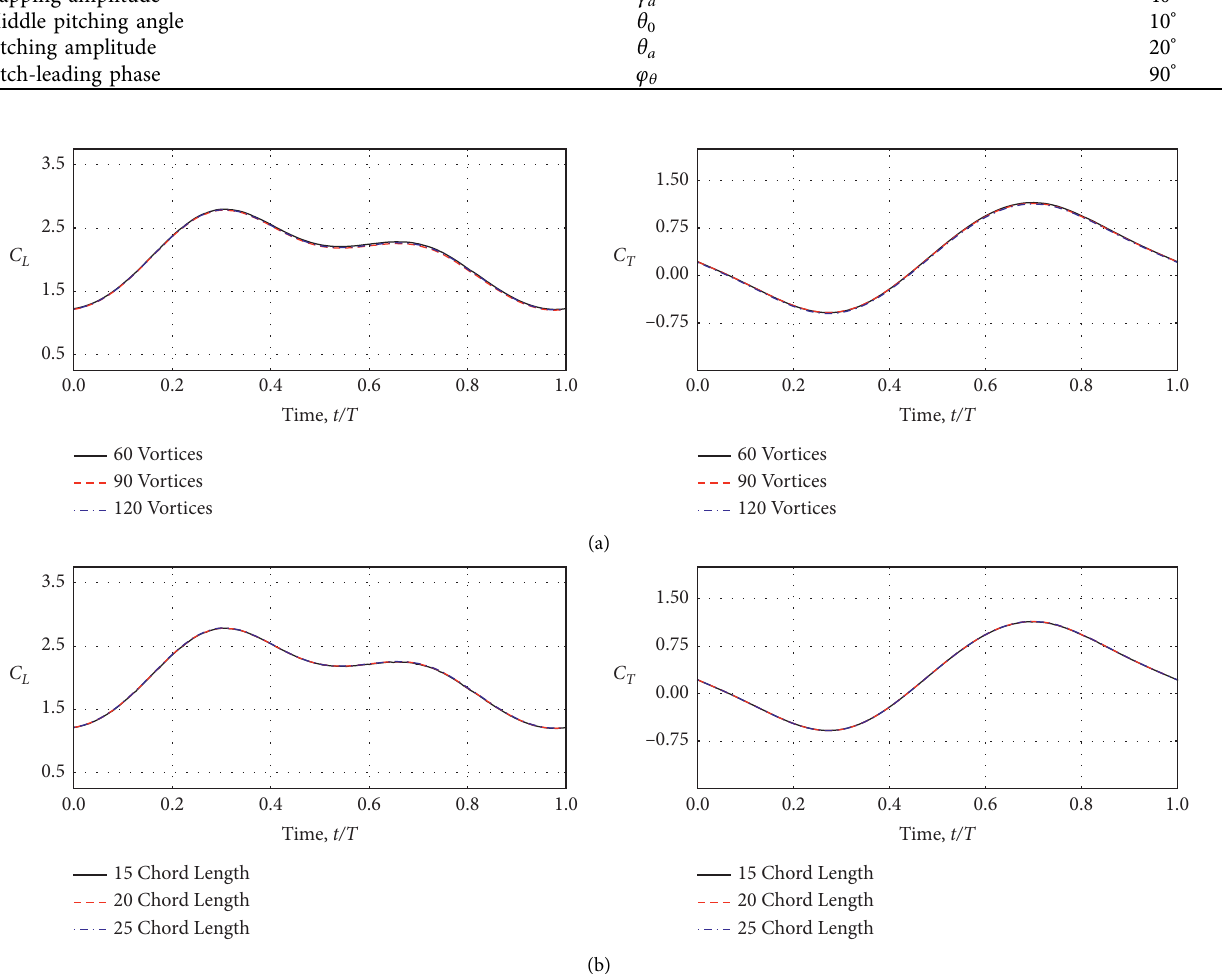
Figure 6: The lift coefficient and thrust coefficient in a complete cycle: (a) 60, 90, and 120 bound vortices; (b) 15, 20, and 25 chord-length wakes.